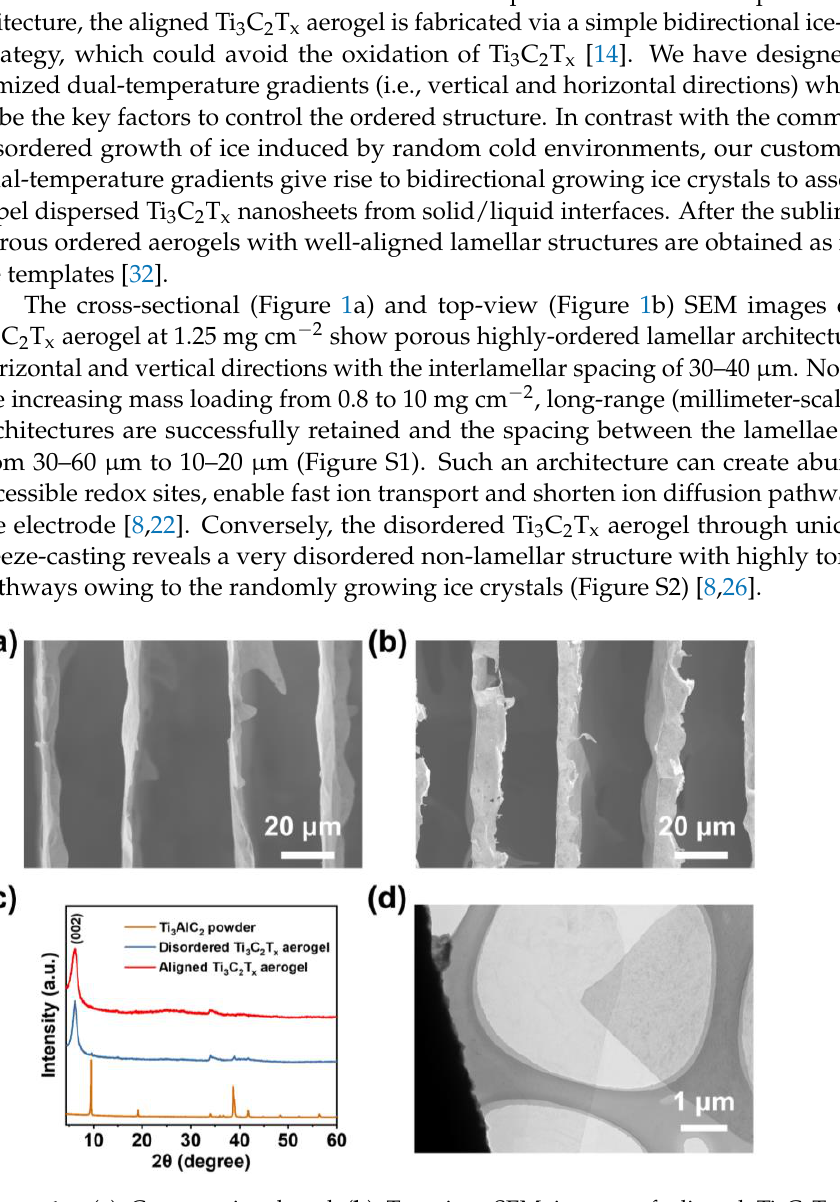
Figure 1. ( a ) Cross-sectional and ( b ) Top-view SEM images of aligned Ti 3 C 2 T x aerogel at 1.25 mg cm −2 ; ( c ) XRD patterns of Ti 3 AlC 2 powder, disordered and aligned Ti 3 C 2 T x aerogel; ( d ) The TEM image of Ti 3 C 2 T x